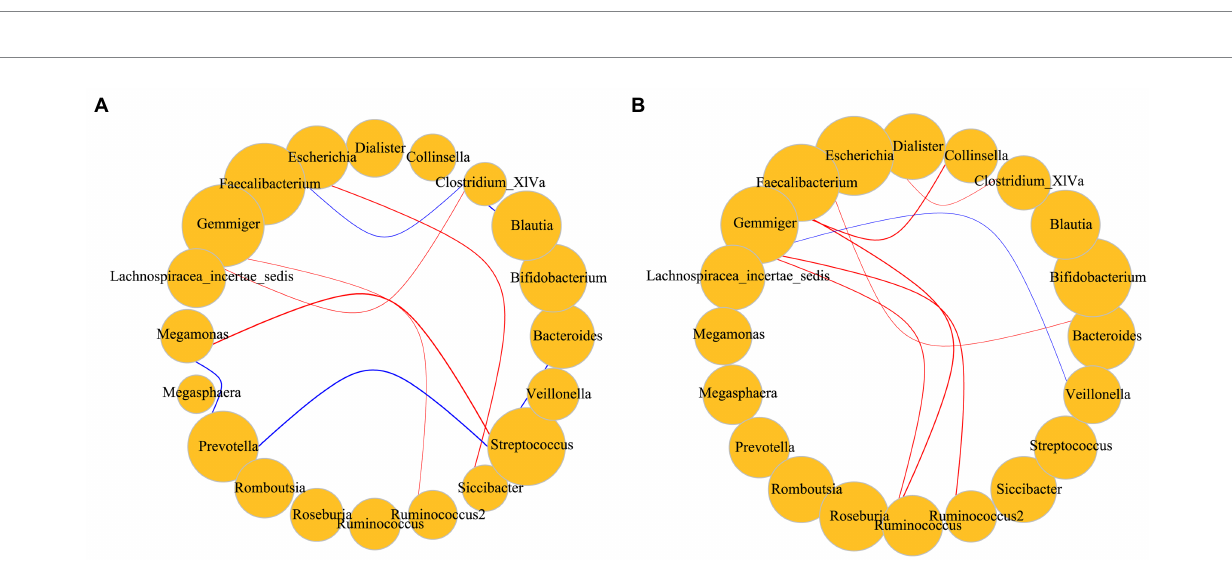
FIGURE 6 (A) Correlations among dominant bacteria in subjects with BMI < 28; (B) Correlations among dominant bacteria in subjects with BMI > 28. Red represents a positive correlation; blue represents a negative correlation. Size represents the relative abundance of the genus, including only dominant bacteria. The p value for significant correlations are less than 0.05 and the absolute value of the correlation distance calculated by the Spearman method is greater than 0.45. Correlation of the gut microbiota was analyzed using the Hmisc package and igraph package in R